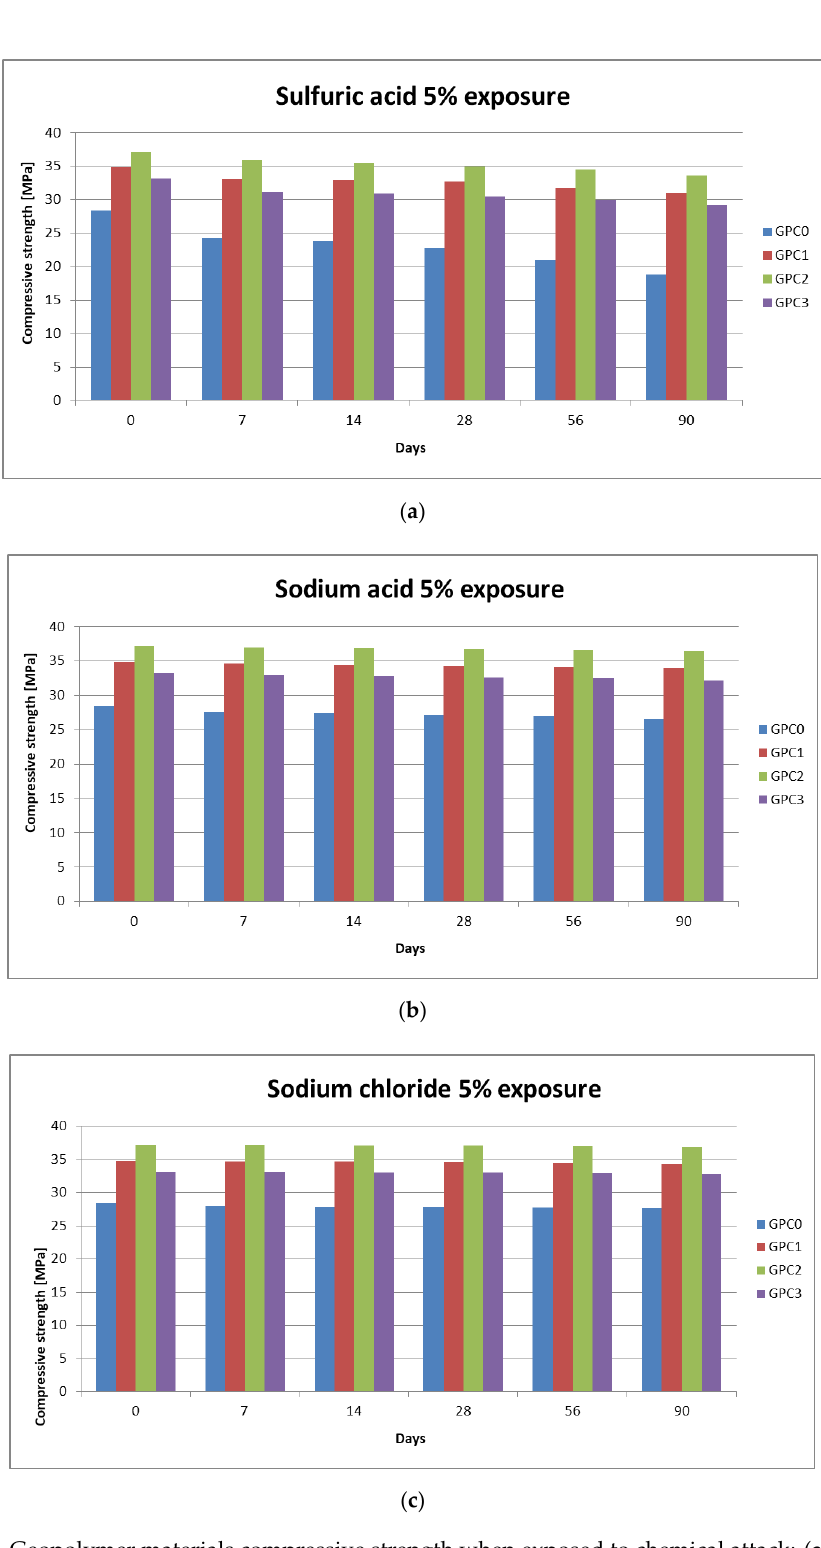
Figure 2. Geopolymer materials compressive strength when exposed to chemical attack: ( a ) sulfuric acid exposure; ( b ) sodium acid exposure; ( c ) sodium chloride exposure. acid exposure; ( b ) sodium acid exposure; ( c ) sodium chloride